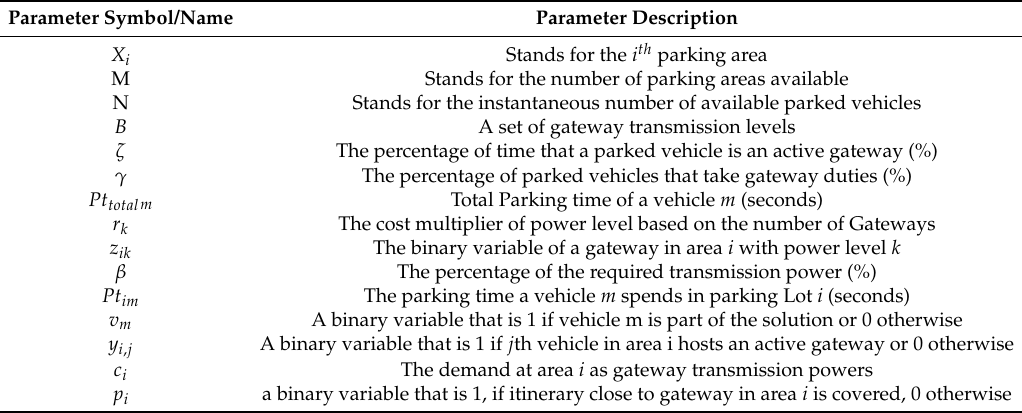
Table 1. Model parameters, and their Descriptions.